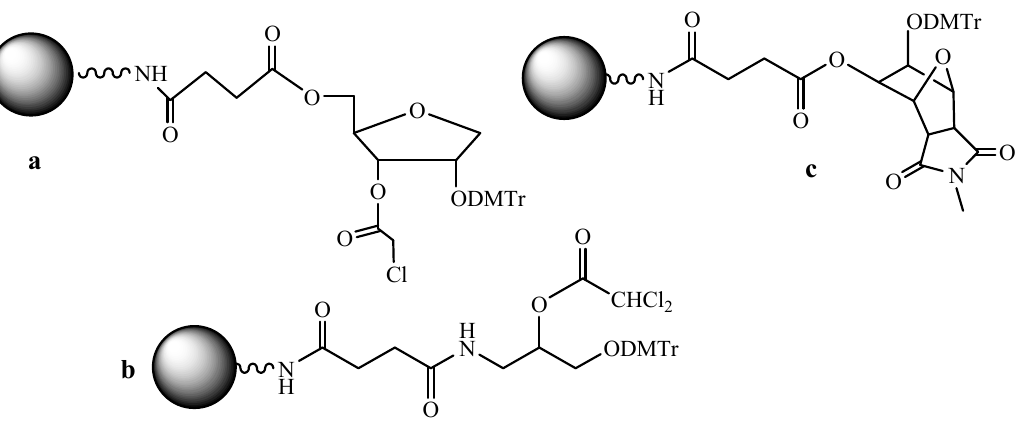
Figure 5. Universal supports for ODN